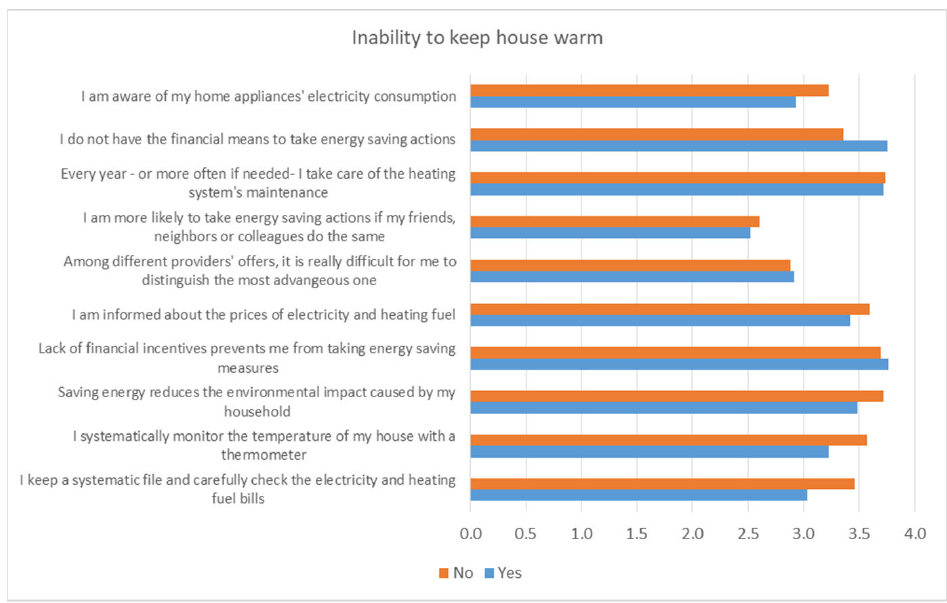
Figure 9. Behavioral statements by energy ‐ vulnerable and non ‐ vulnerable households—“arrears in energy bills” indicator.